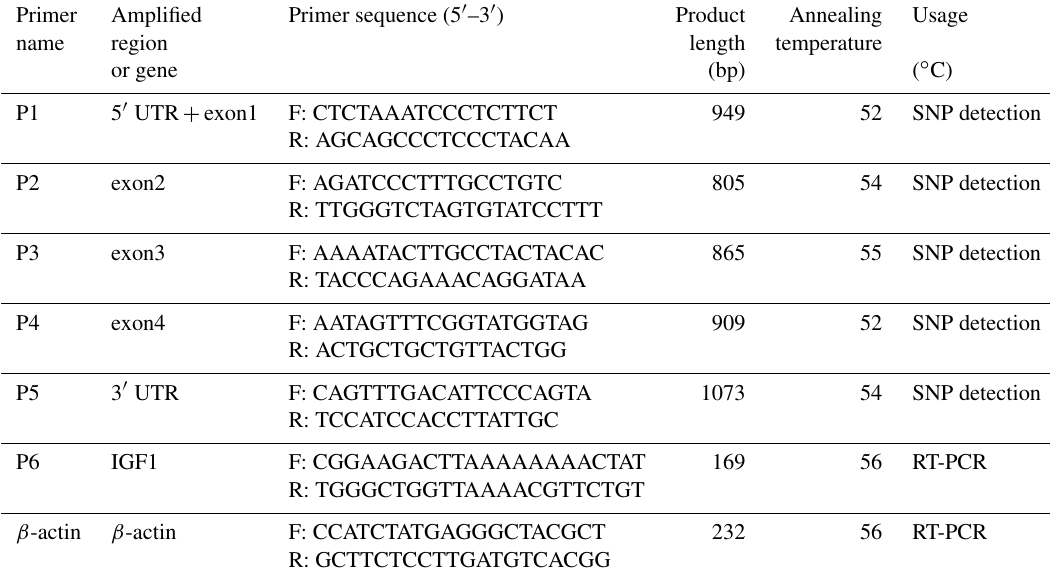
Table 1. Primer information of IGF1 and a reference gene in geese. Primer Amplified Primer sequence (5 (cid:48) –3 (cid:48) ) Product Annealing